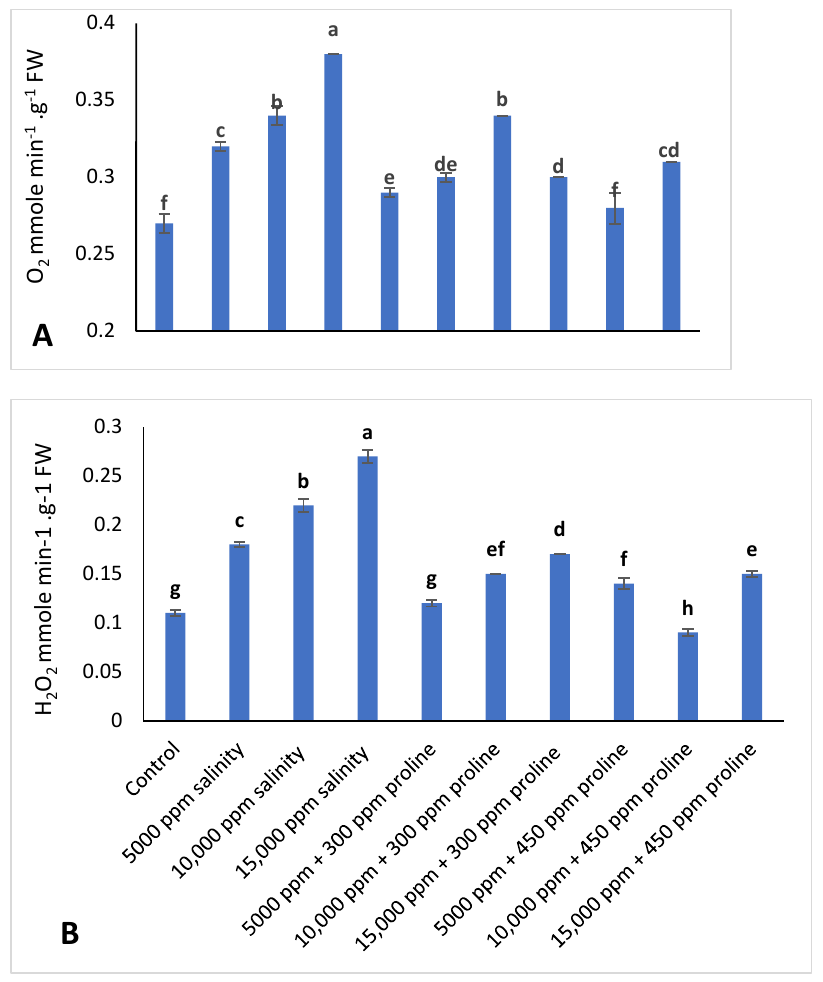
Figure 7. Effect of different levels of seawater salinity and exogenous proline at three concentrations, 0 ppm, 300 ppm, and 450 ppm, on O 2• − (mmol min − 1 g − 1 FW) ( A ) and H 2 O 2 (mmol min − 1 g − 1 FW) ( B ). Data are means of two seasons (2020 and 2021) and three replicates ( n = 3) each season. The mean values ± SE of each parameter followed by different alphabetical letters are significantly different according to Duncan’s multiple range test at p ≤ 0.05.